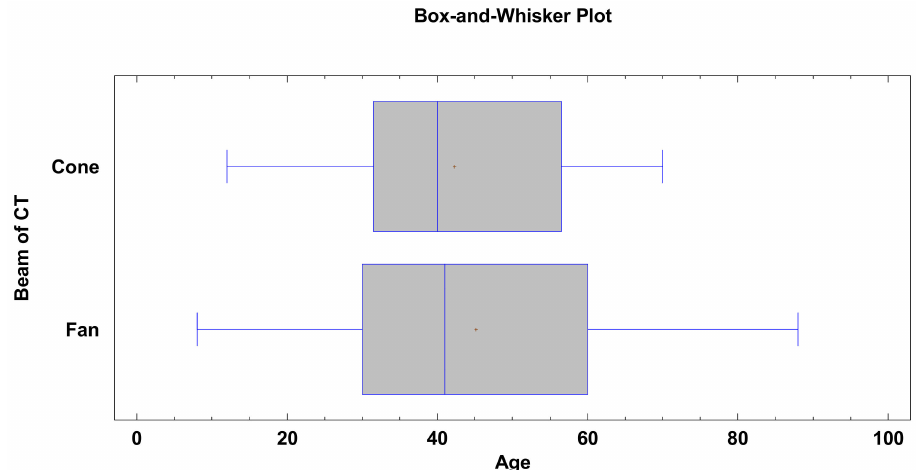
Figure 2. Results showing statistically insignificant ( p > 0.05) differences between the age of patients and the type of computer tomography (CT) subjected to segmentation.